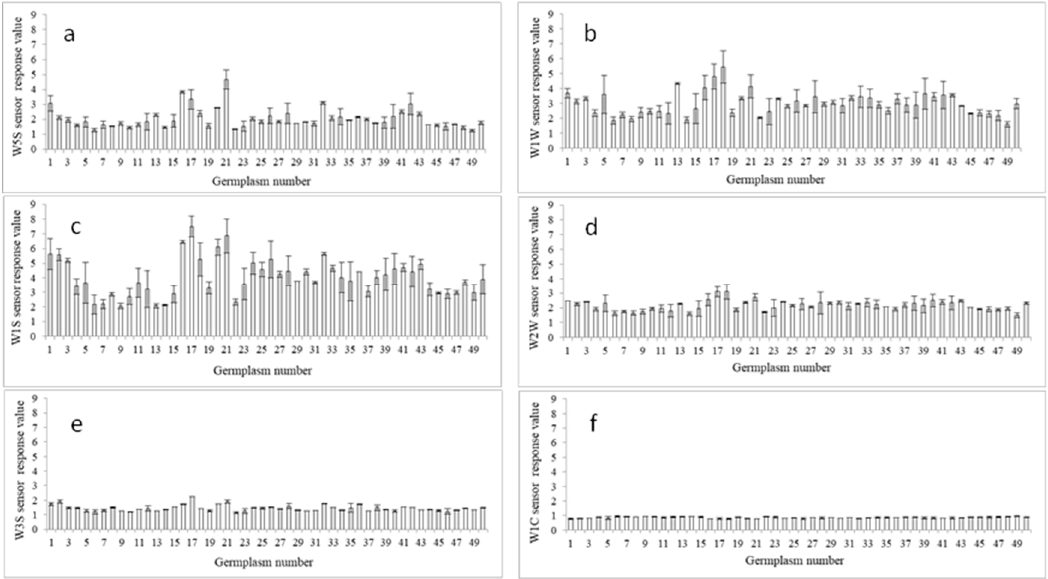
Figure 4. Comparison among the response values for the three main sensors and the three aro- matic sensors. Note: ( a ): W5S (sensor for nitrogen oxides), ( b ): W1W (sensor for hydrogen sulfide), sensors. Note: ( a ) W5S (sensor for nitrogen oxides), ( b ) W1W (sensor for hydrogen sulfide), ( c ) W1S ( c ):W1S (sensor for methane compounds), ( d ): W2W (sensor for aromatic components and organic (sensor for methane compounds), ( d ) W2W (sensor for aromatic components and organic sulfide), sulfide), ( e ): W3S (sensor for ammonia), and ( f ): W1C (sensor for aromatic benzene). ( e ) W3S (sensor for ammonia), and ( f ) W1C (sensor for aromatic